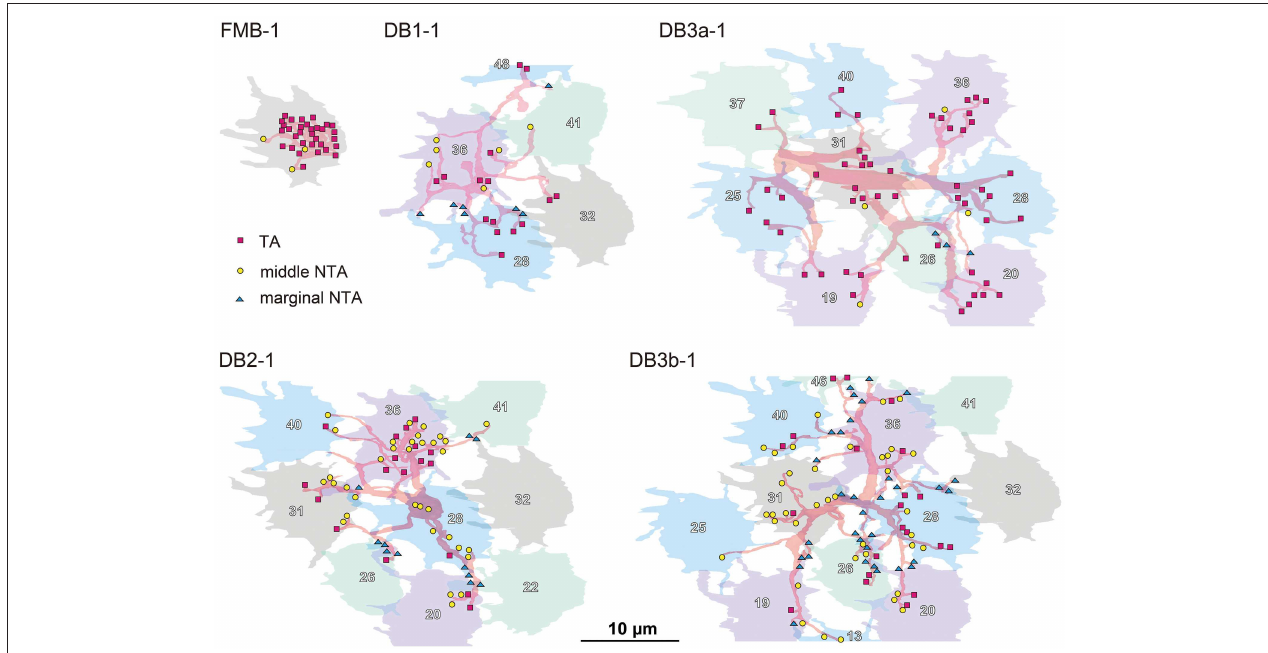
FIGURE 4 | Distributions of the three positional classes of basal synapses for the five OFF bipolar cell types. The dendrites (pale red) of the five types of OFF bipolar cells form basal synapses with cone pedicles (different colors with serial pedicle numbers). The synaptic contacts are categorized according to their basal positions as TA (magenta square), middle NTA (yellow circle), and marginal NTA (cyan triangle).